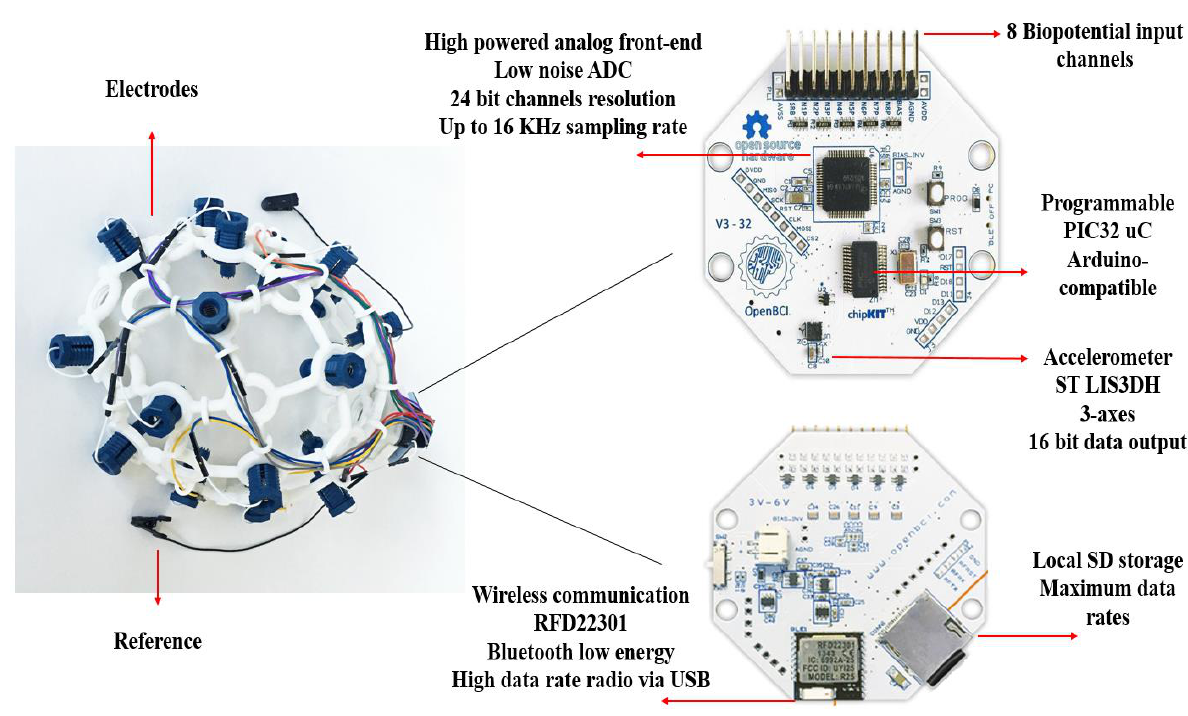
Fig. 2. Ultra-cortex mark IV headset with the